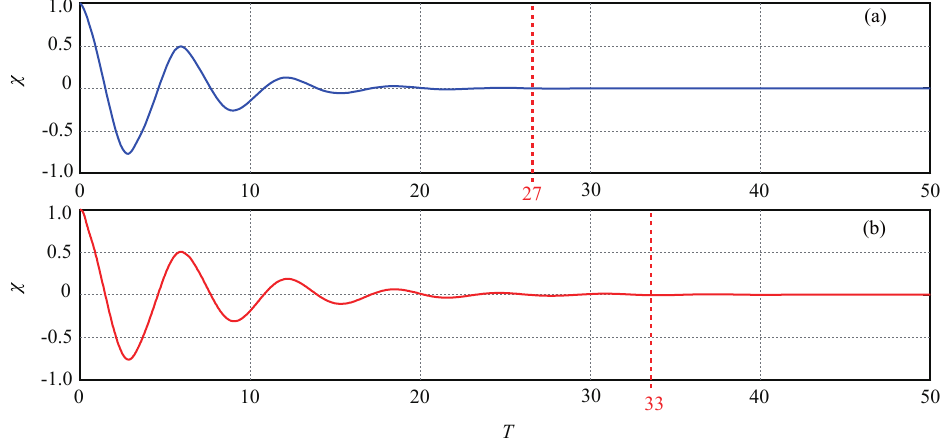
Figure 3. Curves of the dimensionless trolley displacement with a continuous disturbance [( a ) Pro- posed method; ( b ) Method in